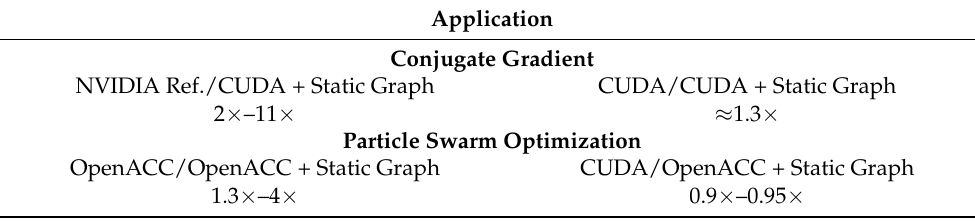
Table 2. Overall performance benefit using Static